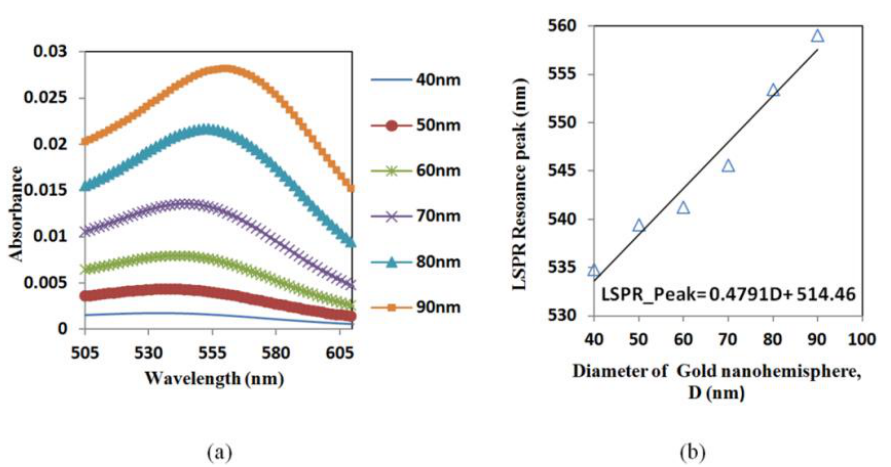
Figure 2. ( a ) Optical absorbance spectrum of gold nano-hemisphere ( b ) a red-shift of peak wavelength against the size of the gold